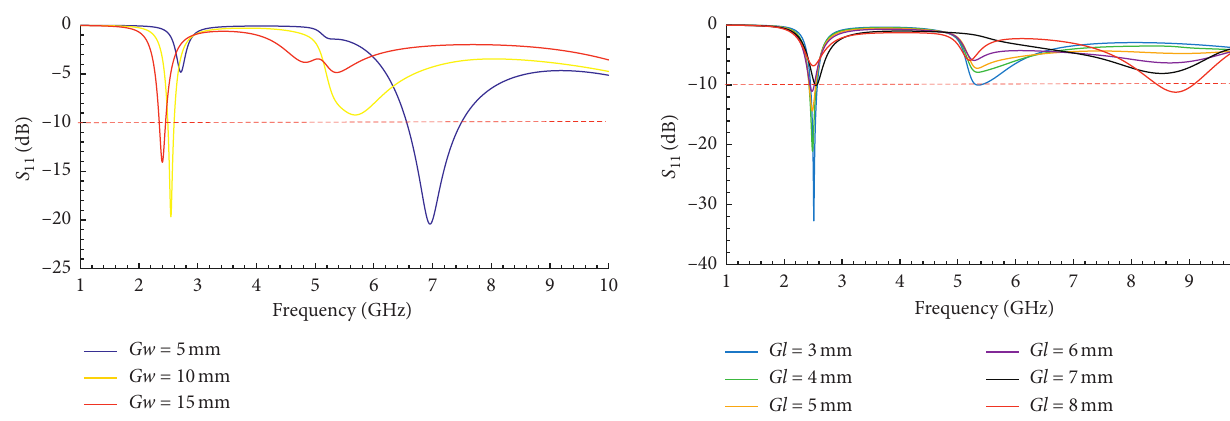
G w variation in Vine-leaf BioAs-